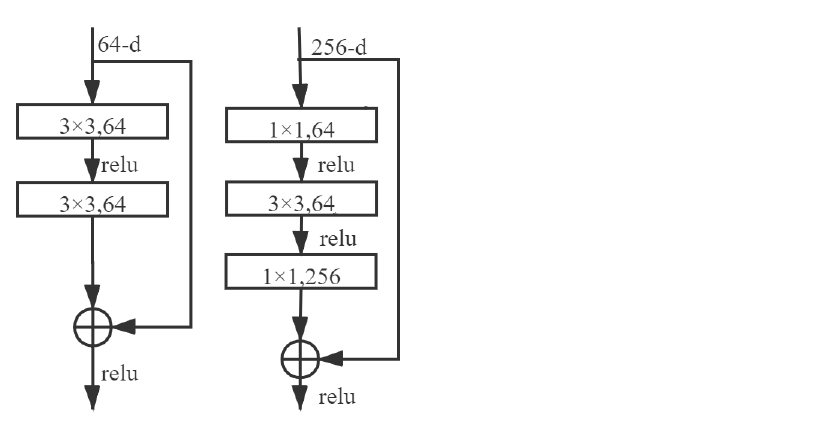
Figure 8. Two blocks in ResNet series diagrams: the left is BasicBlock and the right is Bottleneck. In the ResNet series, the types and counts of blocks in each layer vary from one network to another. ResNet18, whose architectures are shown in Figure 9 and ResNet34, are built with BasicBlock. While ResNet50, ResNet101, and ResNet152 are composed of Bottleneck. The block structures of them are shown in Table 2. Table 2. The number of blocks in each layer of ResNet